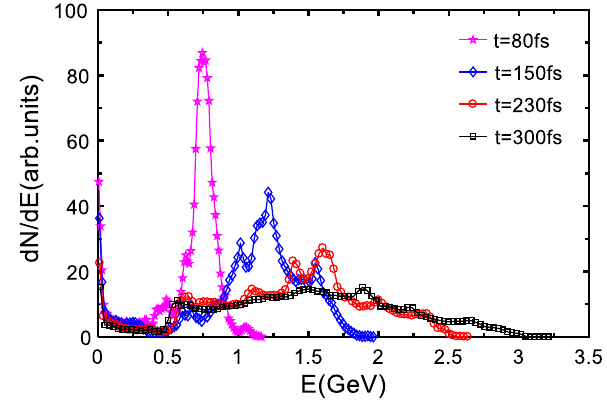
FIG. 1. Energy spectrum of protons for a common RPA at four time instants: t ¼ 80 fs, t ¼ 150 fs, t ¼ 230 fs, and t ¼ 300 fs. Here, the protons in the region of − 6 λ ≤ y ≤ 6 λ are chosen as statistical